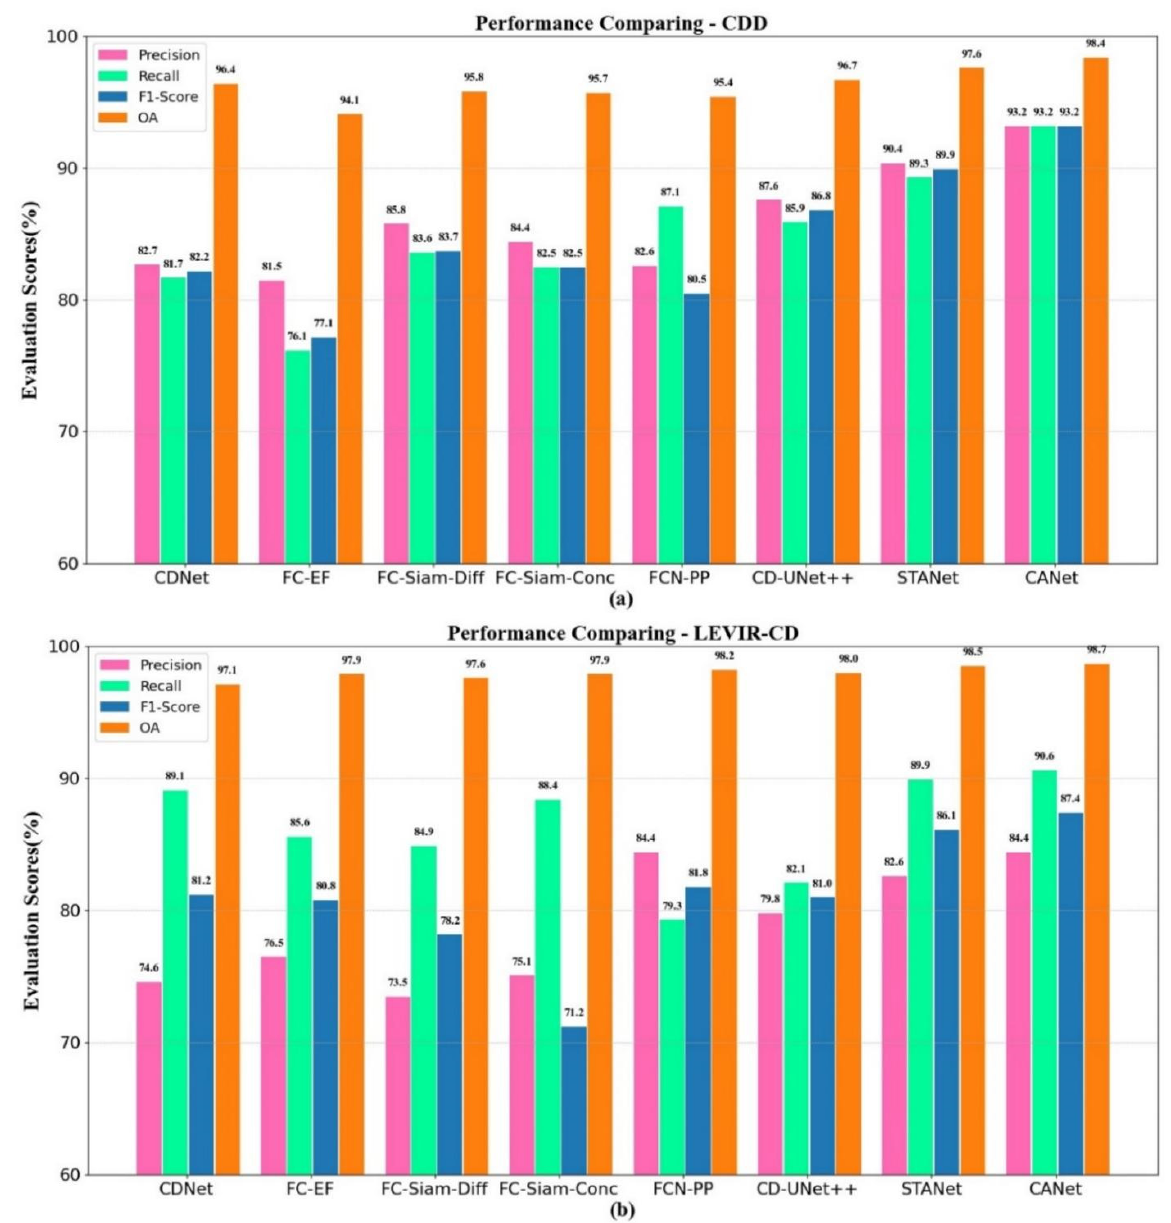
Figure 10. The performance of different models: ( a ) the evaluation scores of CDD dataset; ( b ) the evaluation scores of LEVIR-CD dataset.